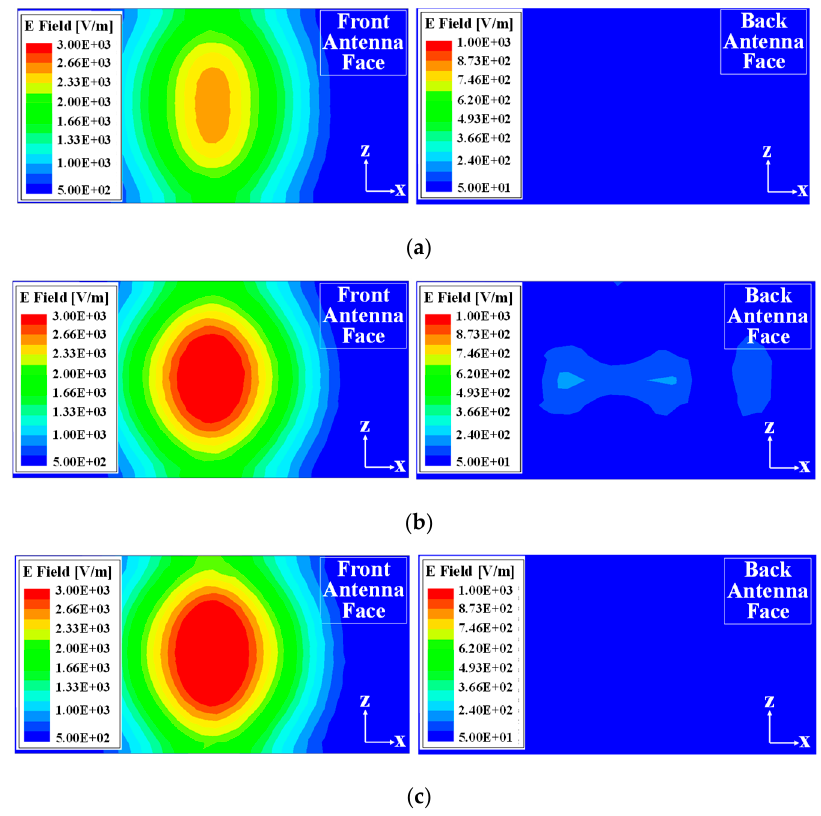
electric field at the dipole front face at θ T = 95° and 120°.